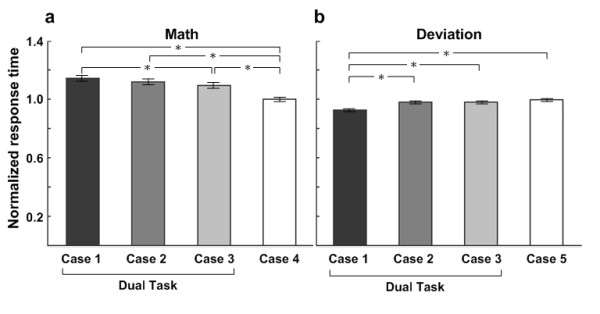
This shows the bar charts of normalized response times. (a) for the math task and (b) for deviation task across 15 subjects. The filled black bar: case 1; dark gray bar: case 2; light gray bar: case 3; the open bar: single case. The response time for math task in dual-task cases (case 1, case 2, and case 3) is significantly longer than that for in single task (case 4). The shortest response time for the math onset is in case 4. The response time for deviation task in case 1 is significantly shorter than those in other cases. The longest response time to the deviation onset is in case 5. The bottom insets show the onset sequences of the two tasks.